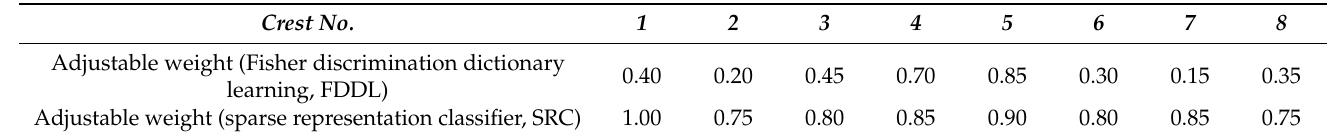
Table 3. Adjustable weights for each